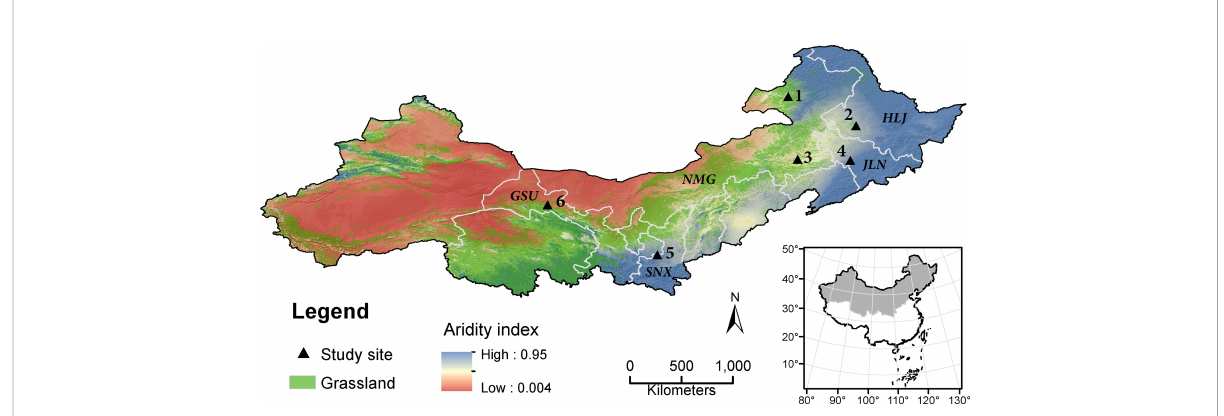
FIGURE 1 The study sites in relation to the regional distribution of grasslands and climatic aridity. Grassland is extracted from ESA CCI land cover v2.0.7 for the year 2015. The aridity index is evaluated as the rainfall to potential evapotranspiration ratio, averaged for the period 1970-2000. Site